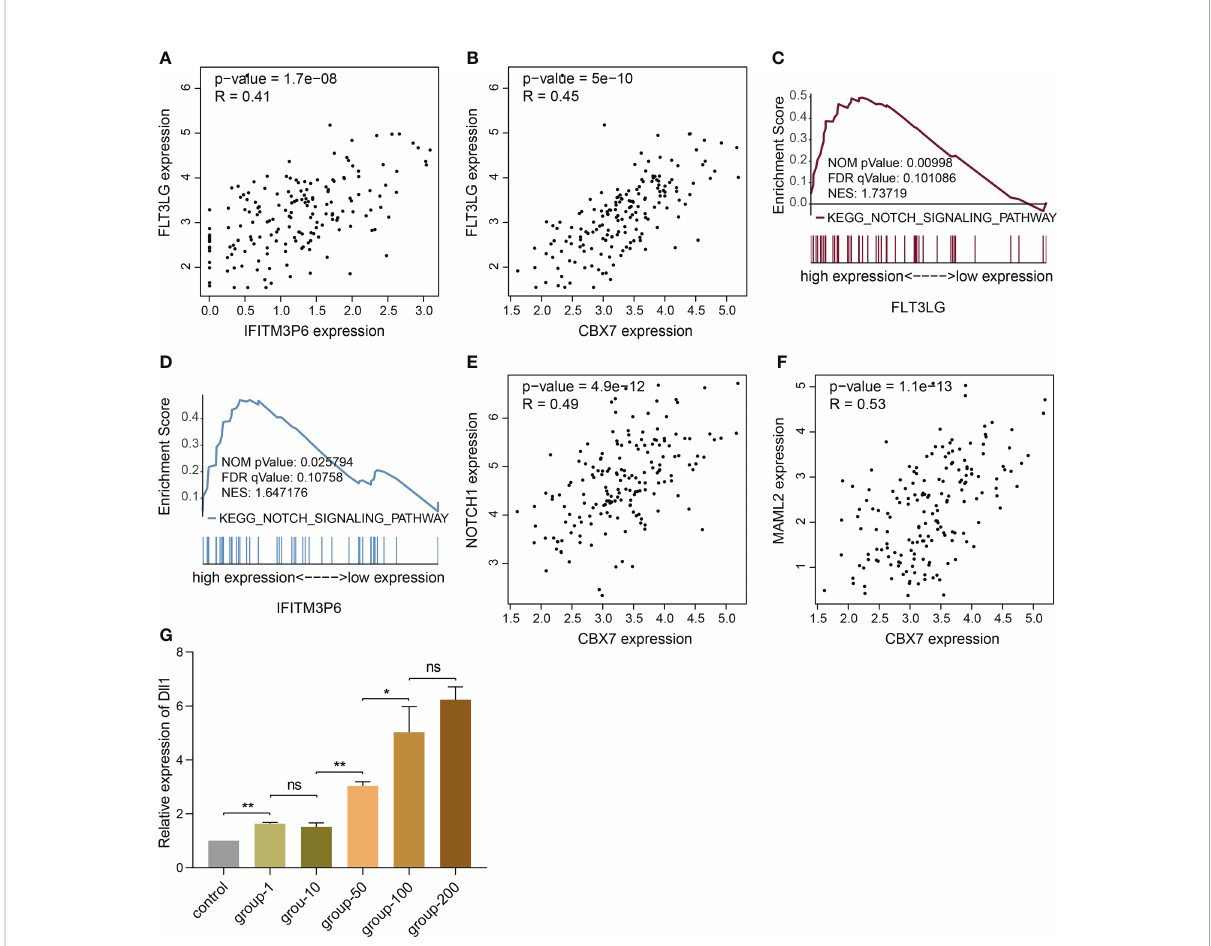
FIGURE 9 The potential relationship of FLT3LG and IFITM3P6 in activating T cells. (A) FLT3LG is signi fi cantly correlated with IFITM3P6 in TCGA data. (B) FLT3LG is positively correlated with CBX7. (C, D) FLT3LG and IFITM3P6 are enriched in NOTCH signaling pathway. (E, F) CBX7 is positively correlated with NOTCH1 and MAML2. (G) Dll1 is increased in rat bone marrow-derived dendritic cells along with elevated concentration ( m g/ml) of Flt3lg stimulation. * p < 0.05; ** p < 0.01; ns, no signi fi